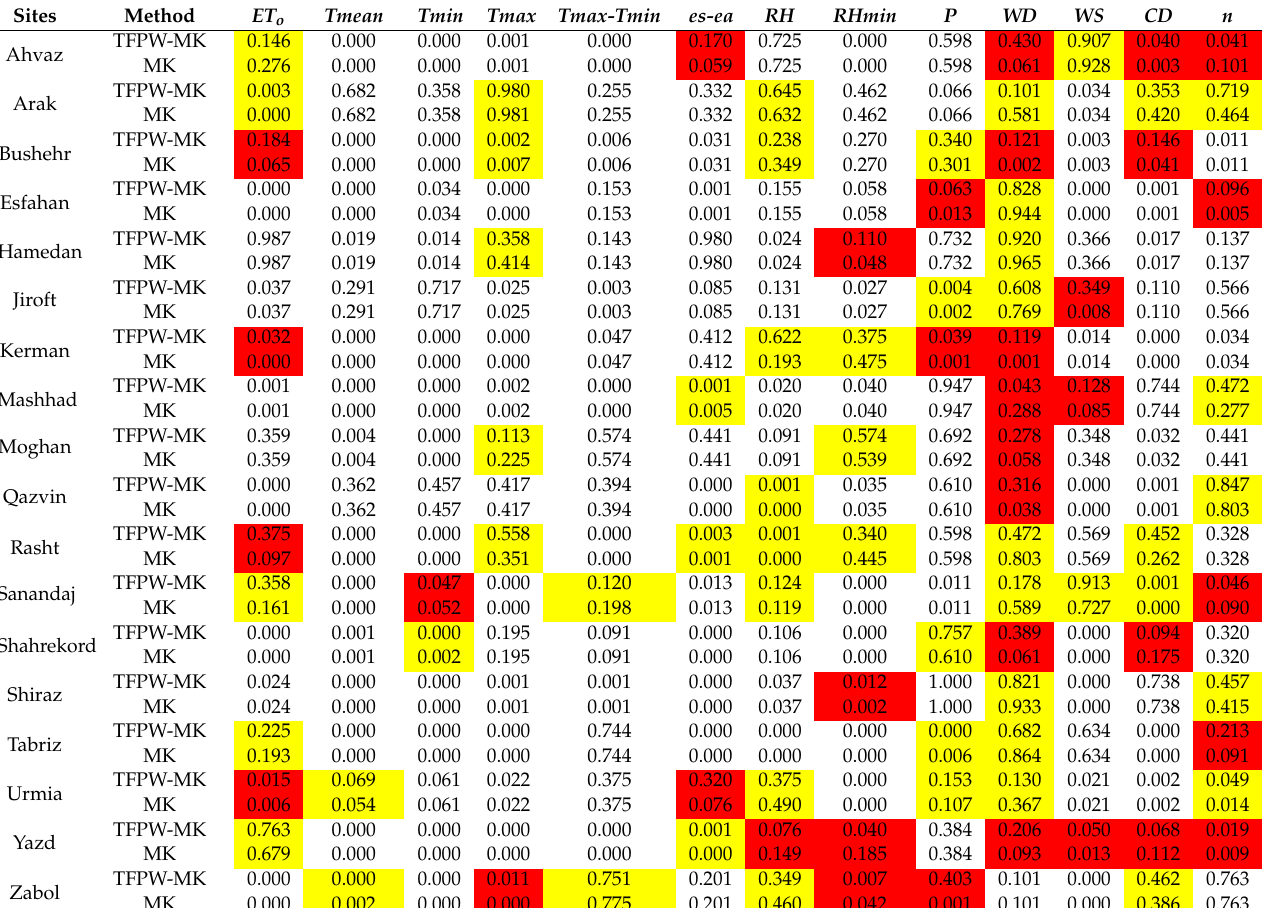
Table 2. Estimated p -values from the Mann–Kendall (MK) and trend-free pre-whitening Mann–Kendall (TFPW-MK) tests in the 18 study